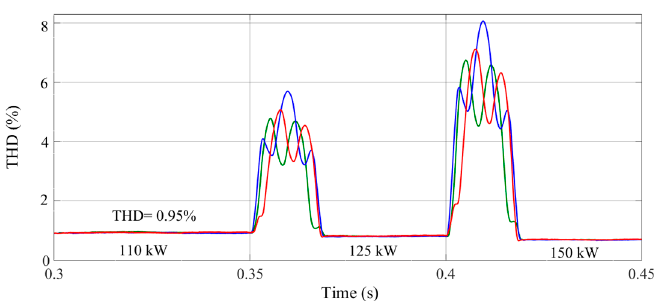
Figure 12. THD of currents i AB , i BC , and i CA . Figure 12. THD of currents 𝑖 (cid:3002)(cid:3003) , 𝑖 (cid:3003)(cid:3004) , and 𝑖 (cid:3004)(cid:3002) . Figure 12. THD of currents 𝑖 (cid:3002)(cid:3003) , 𝑖 (cid:3003)(cid:3004) , and 𝑖 (cid:3004)(cid:3002) .